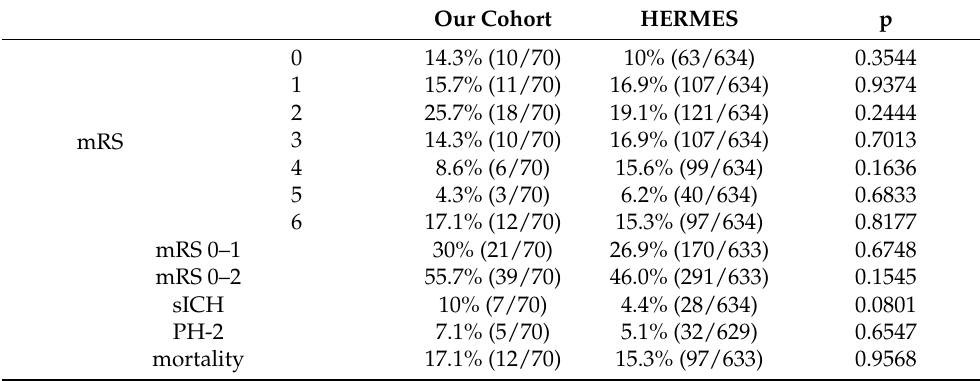
Table 4. Comparison of long-term clinical outcomes (mRS, mRS 0–1, and mRS 0–2 at 90 days) and safety outcomes at 90 days (symptomatic intracranial haemorrhage, parenchymal haematoma type 2, and